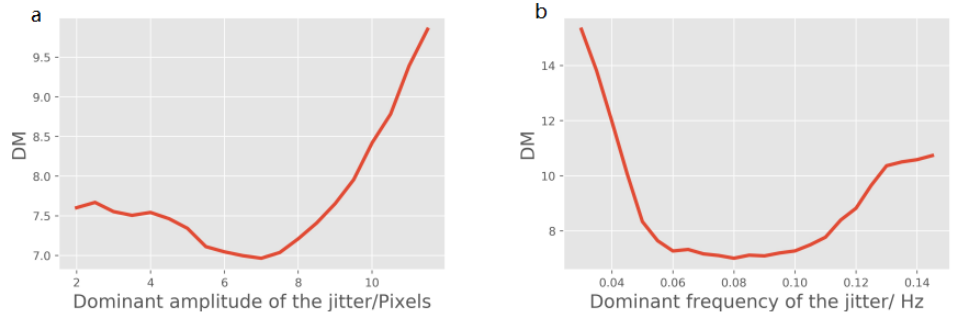
Figure 6. Jitter test results with different dominant frequencies and amplitudes on pretrained RestoreGAN. ( a ): Loss of RestoreGAN for deformed images with different dominant amplitudes; ( b ): Loss of RestoreGAN for deformed images with different dominant frequencies.